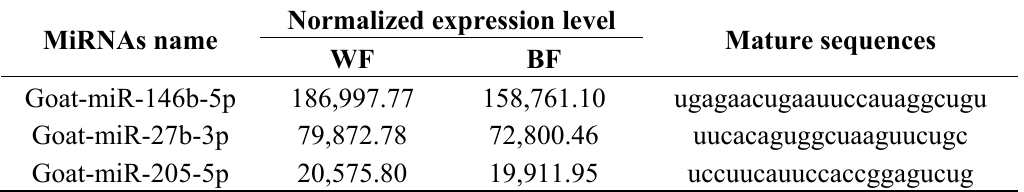
Table 1. The most abundantly expressed miRNAs in goat hair